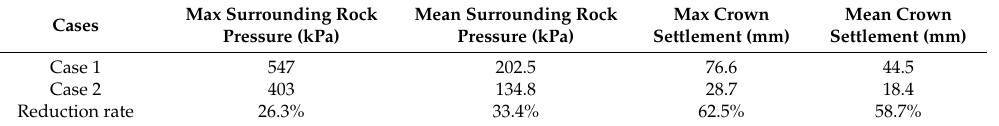
Figure 17. Crown settlements of triple tunnels with PRPS and CGPR. Table 5. Monitoring data comparison of two cases.